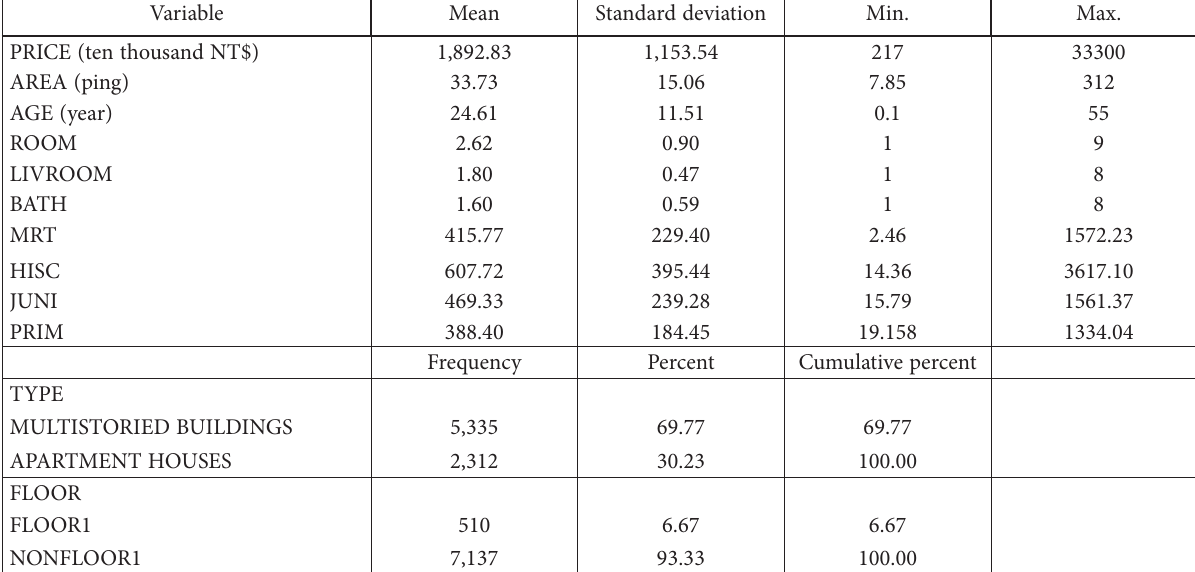
Table 5. Descriptive statistics: After construction – Usage license